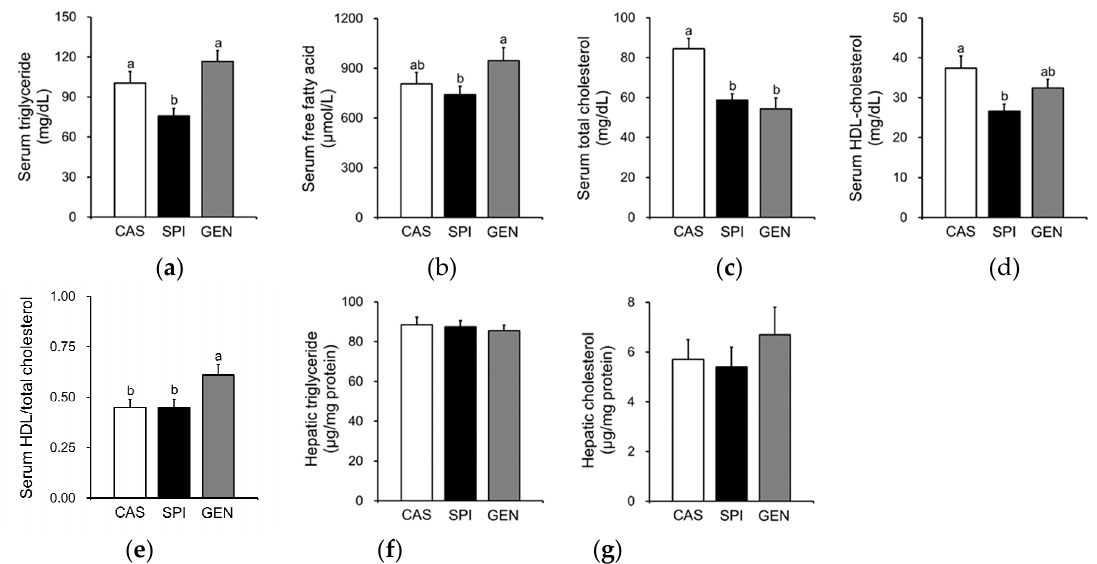
Figure 2. Effects of maternal diet on lipid metabolism of male offspring. ( a ) Serum triglyceride, ( b ) free fatty acid, ( c ) total cholesterol, ( d ) high-density lipoprotein (HDL) cholesterol levels, and ( e ) the ratio of HDL cholesterol to total cholesterol ( n = 8–10); ( f ) Hepatic triglyceride and ( g ) cholesterol levels ( n = 9–11). Data are means ± standard error of the mean. Means with different superscripts are significantly different at p < 0.05.